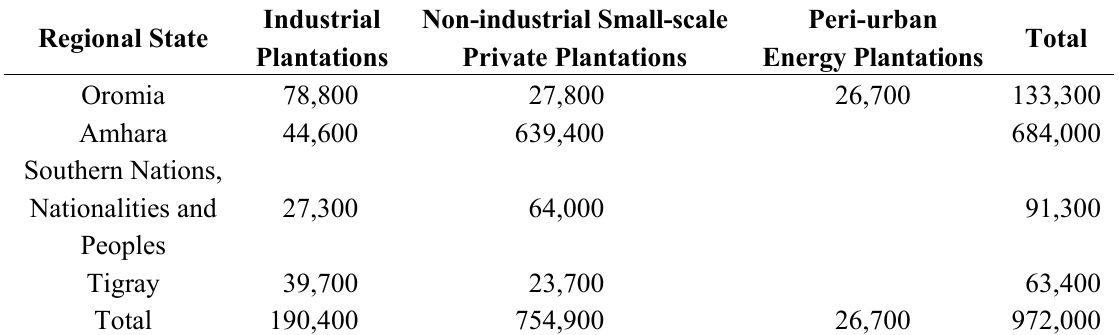
Table 1. Area under Plantation Forests (ha) in Four Major Regional States of Ethiopia (Source: